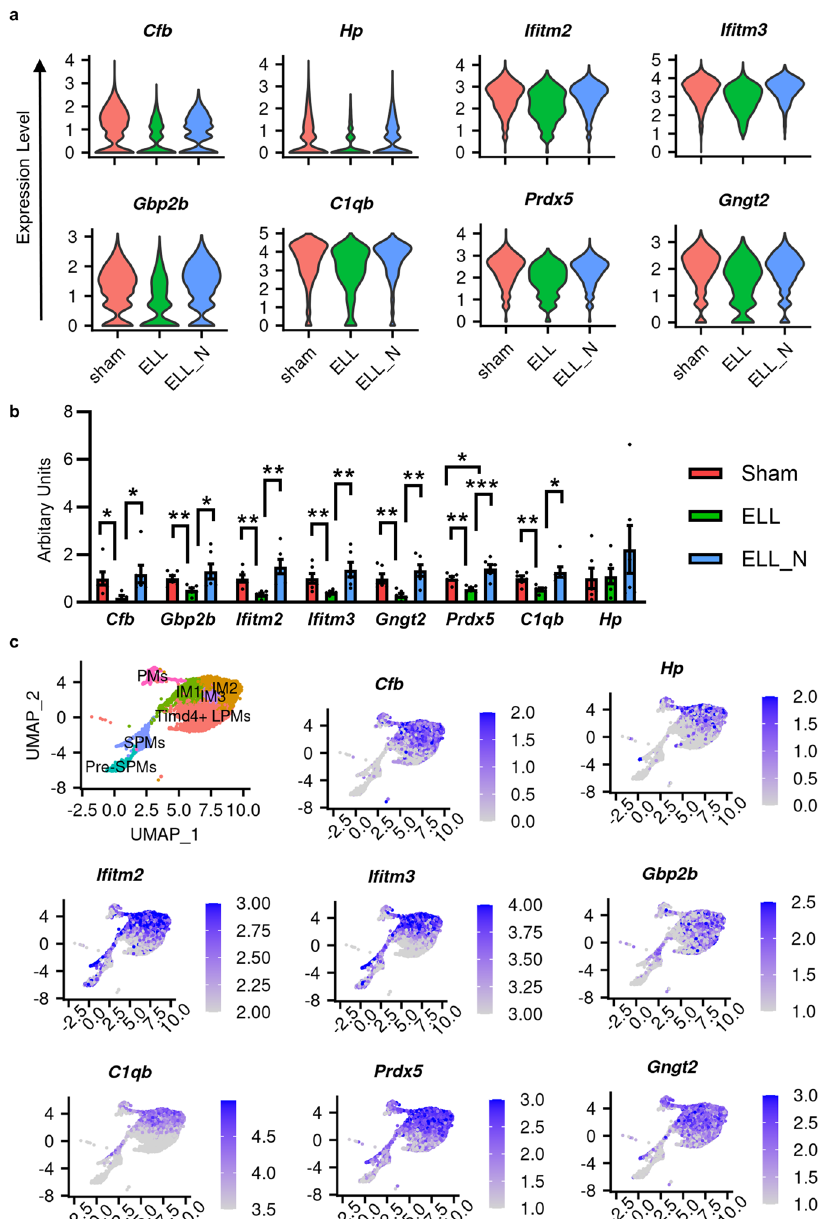
Fig. 5 Genes regulated by ELL and niclosamide and their distributions within the perineal macrophage subpopulations (enhanced by niclosamide). a Vlnplot shows representative genes that were reduced by ELL (ELL/sham) but were enhanced by niclosamide (ELL_N/ELL). All genes shown here were signi fi cantly ( p < 0.05) differentially expressed as determined by the “ wilcox ” test within the Seurat package. b Veri fi cation of differential gene expression by RT-qPCR. * p < 0.05, ** p < 0.01, *** p < 0.001, mean ± SEM, n = 6 per group. c UMAP of computationally selected macrophage populations and the distribution of genes within